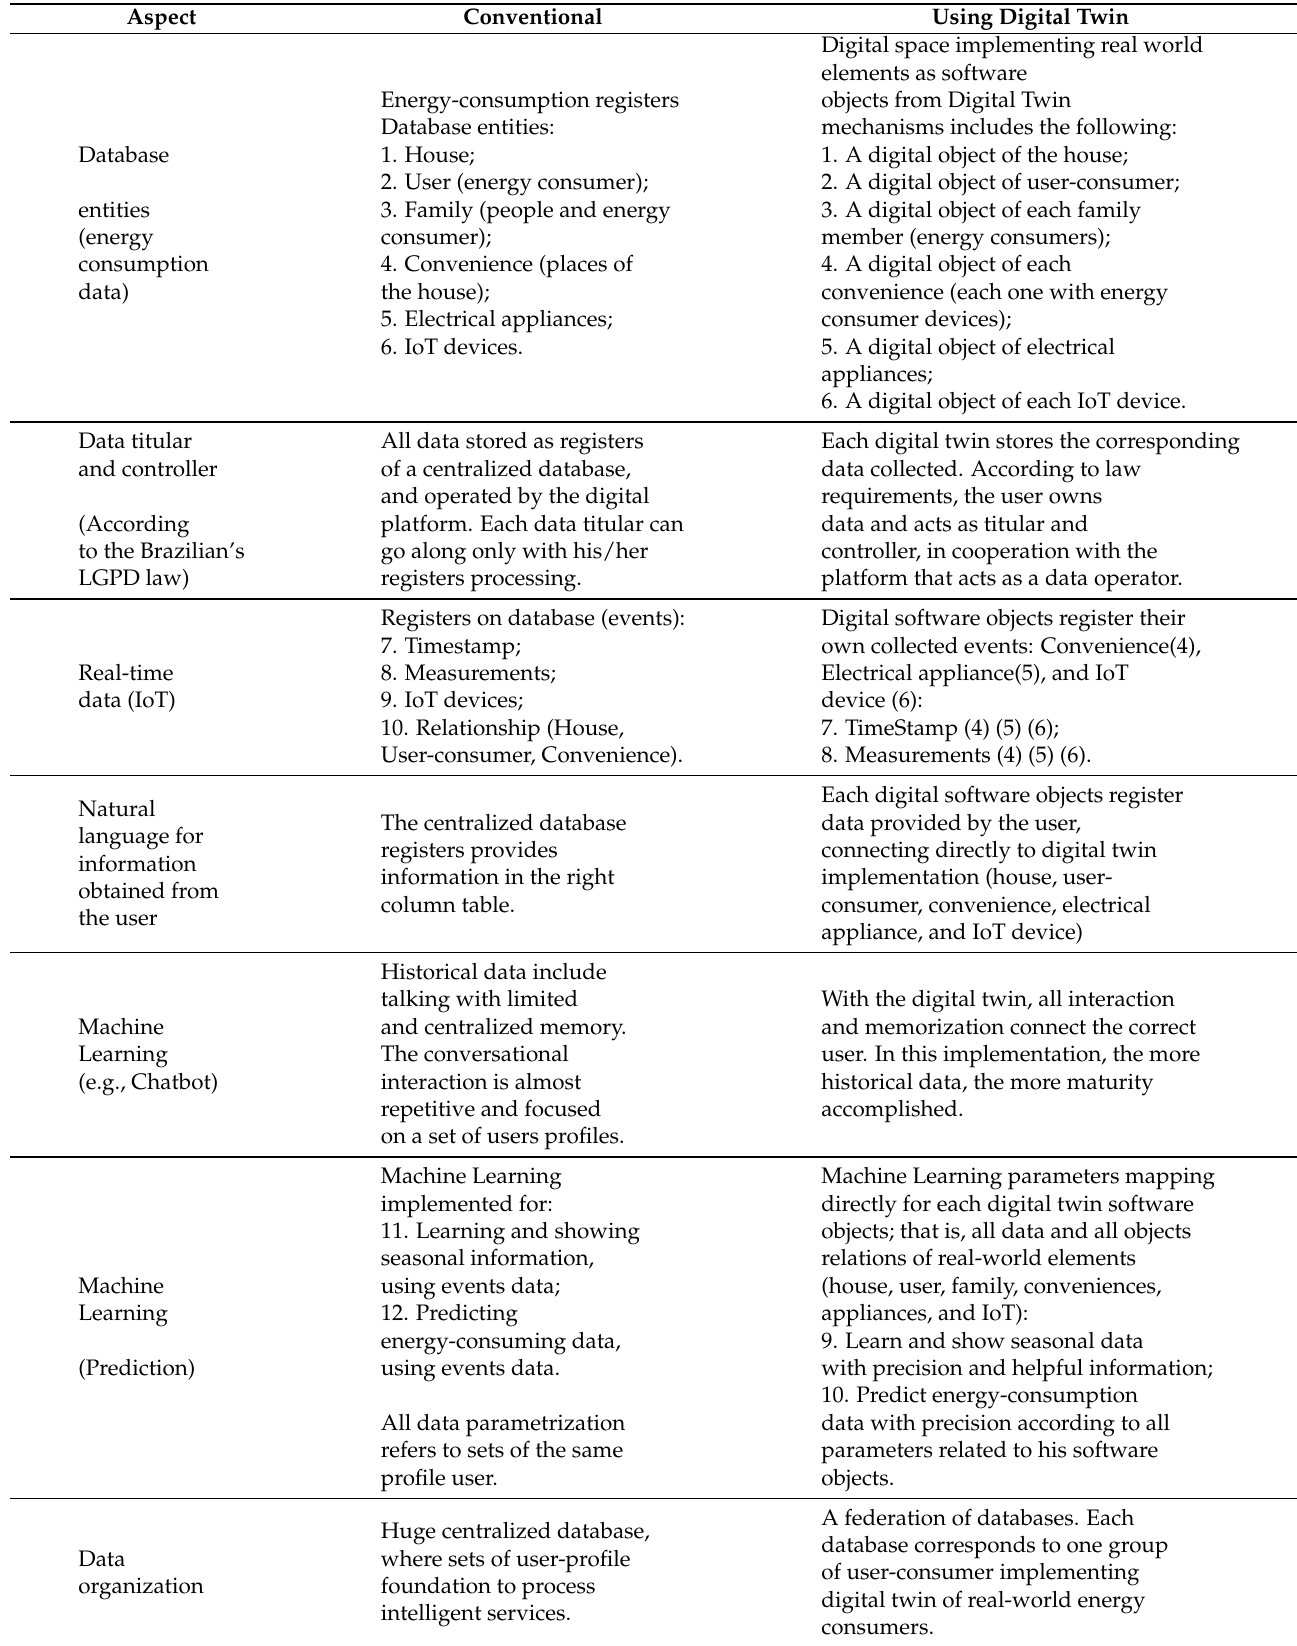
Table 2. Architectural aspects comparison using the Digital